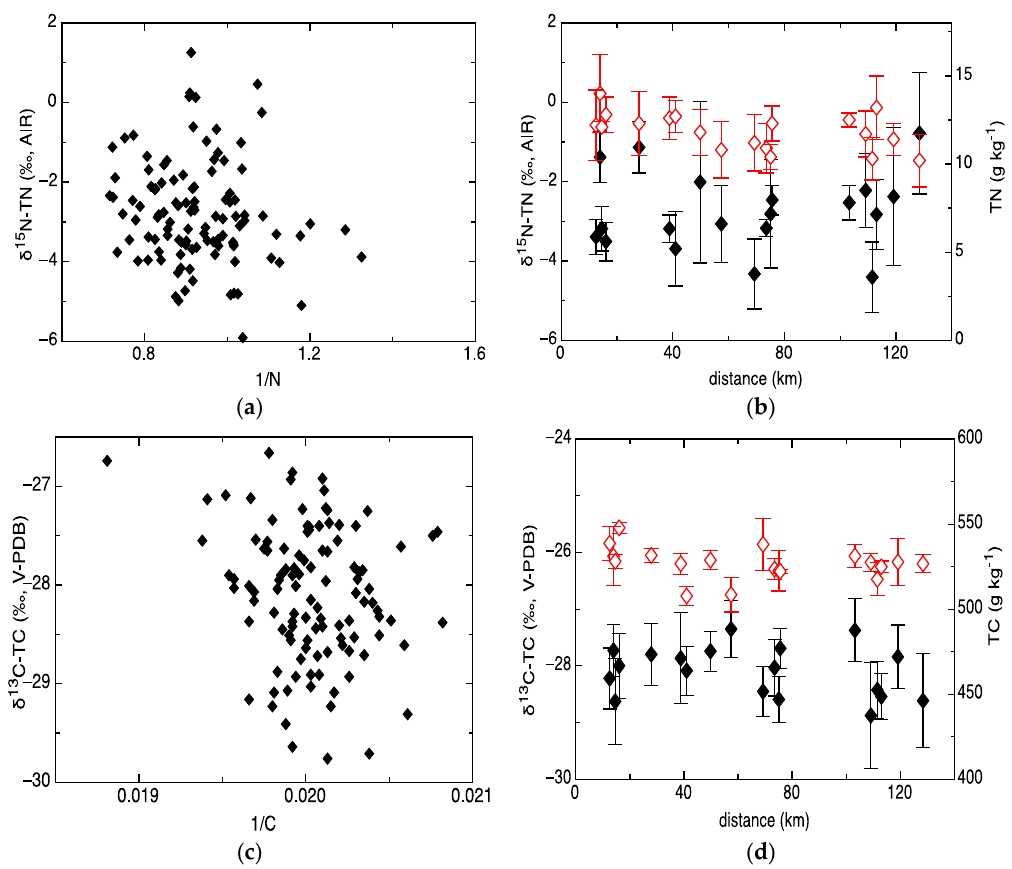
Figure 4. Nitrogen and carbon isotope results from the CAG pine needles. ( a ) δ 15 N values of total nitrogen (TN) versus the inverse TN (wt %) content; ( b ) site averaged δ 15 N values (black diamonds) and TN values (red diamonds) versus distance to the major emission sources in the AOSR; ( c ) δ 13 C